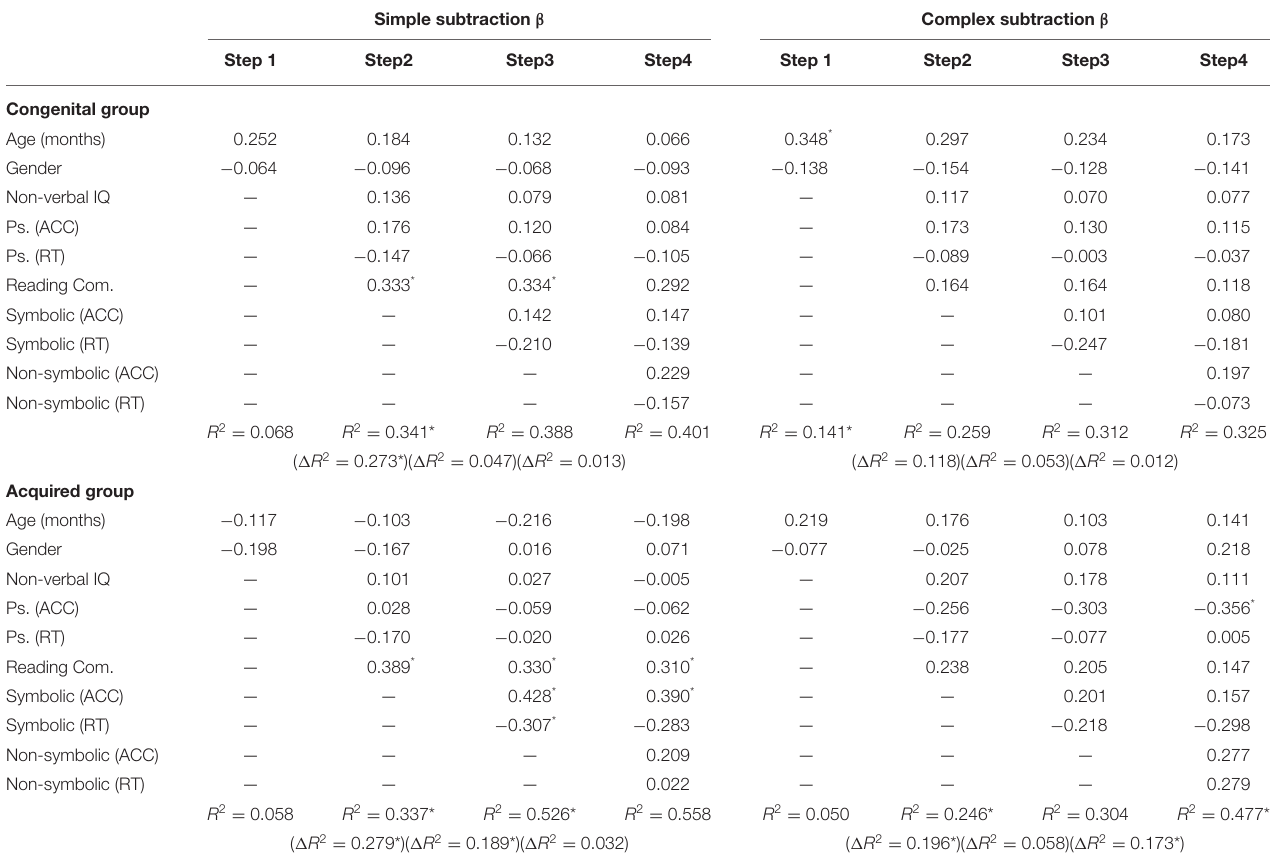
TABLE 4 | Hierarchical regression models predicting arithmetic ability (simple and complex subtraction) from age, gender, general cognitive ability, symbolic, and non-symbolic magnitude processing in congenital and acquired